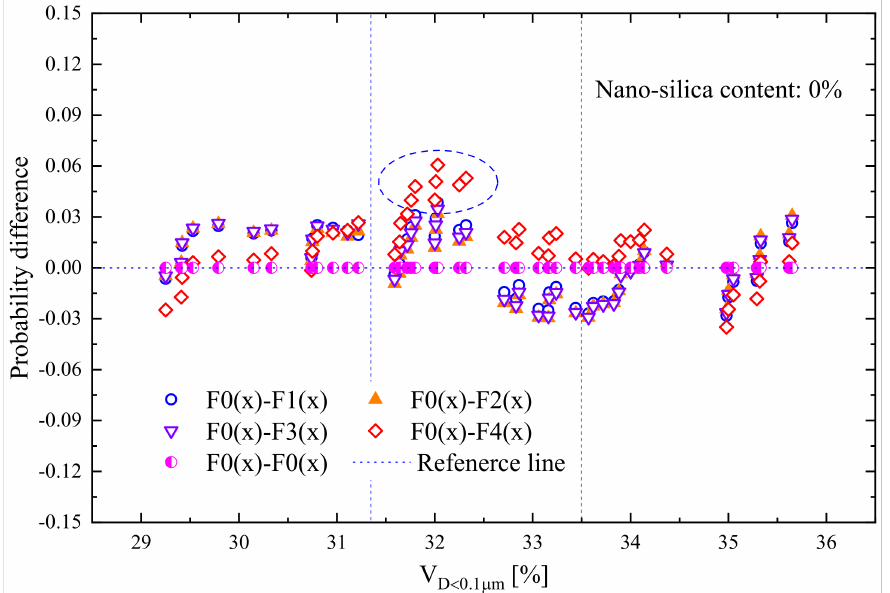
Figure 9. The probability difference between the four distributions and experimental V D < 0.1 µ m . Table 3. The statistical characteristics of probability differences between potential probability distri- bution and measured median pore